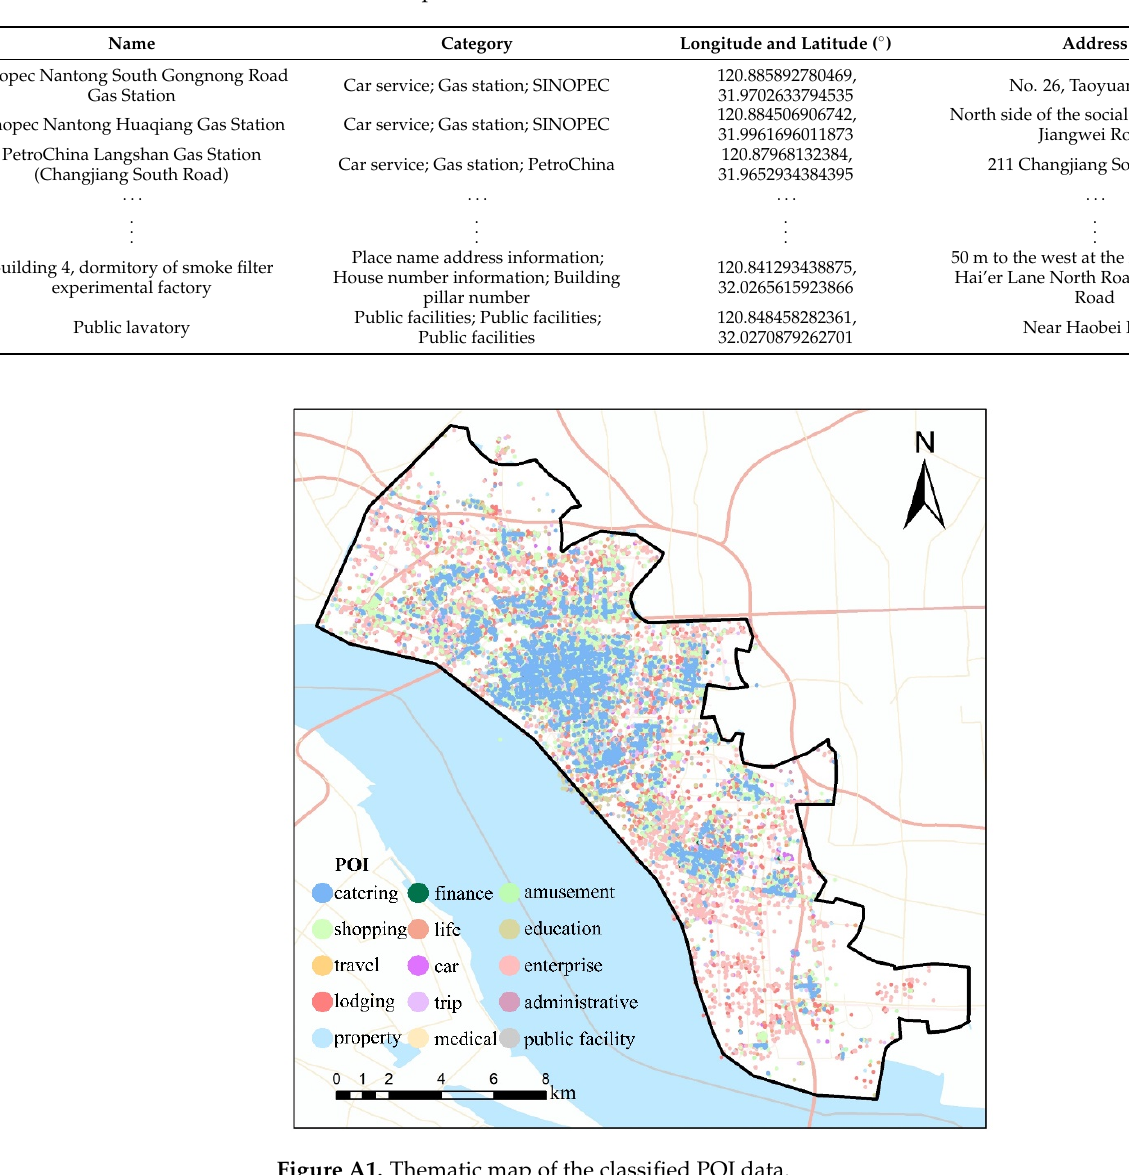
Table A1. Samples of the POI data derived from the web crawler.